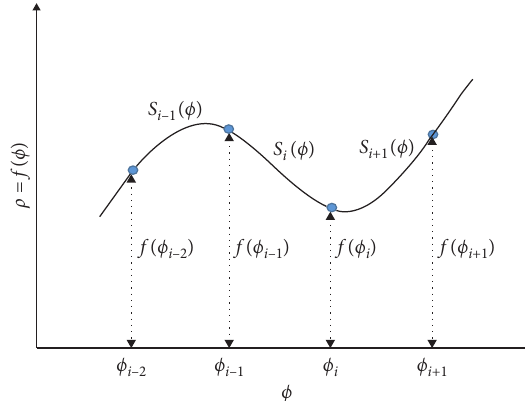
Figure 4: Illustration of the cubic spline